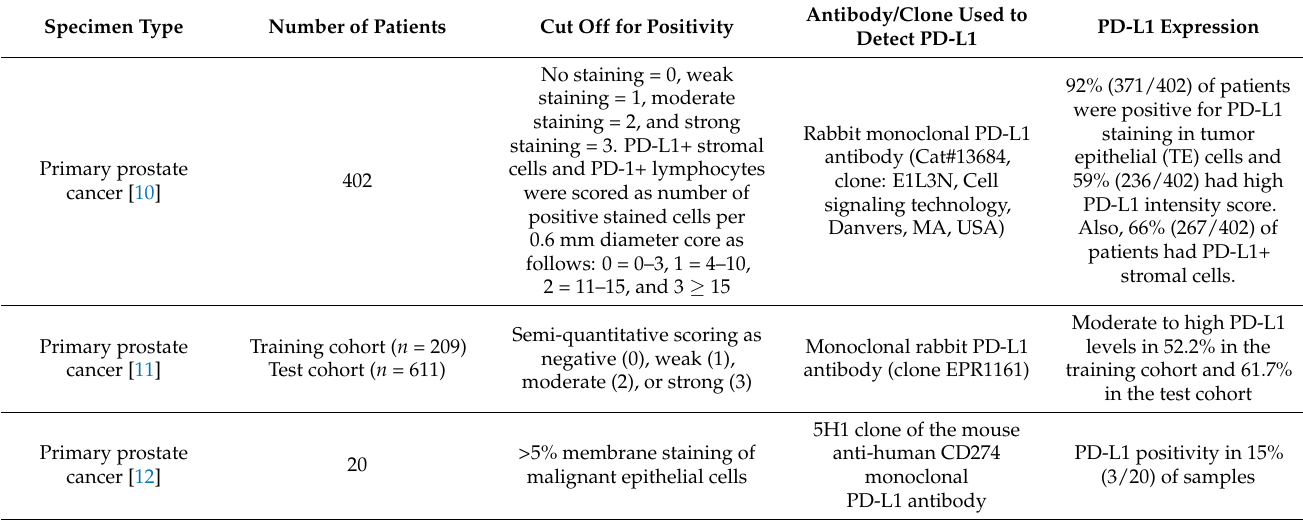
Table 1. Studies examining PD-1/PD-L1 expression in prostate